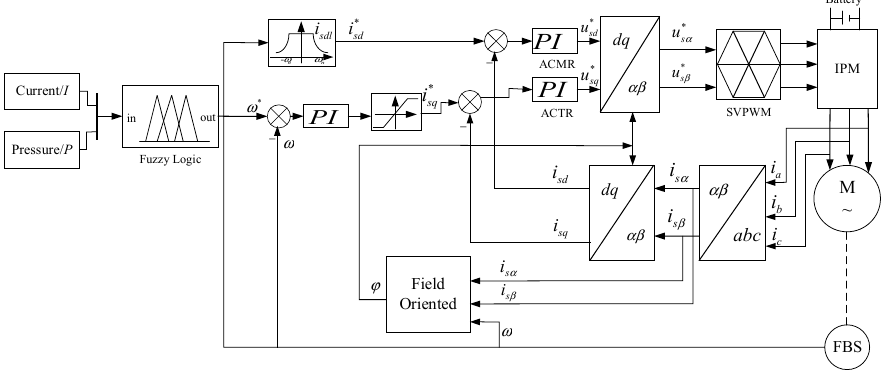
Figure 9. Cutting motor Simulink model.